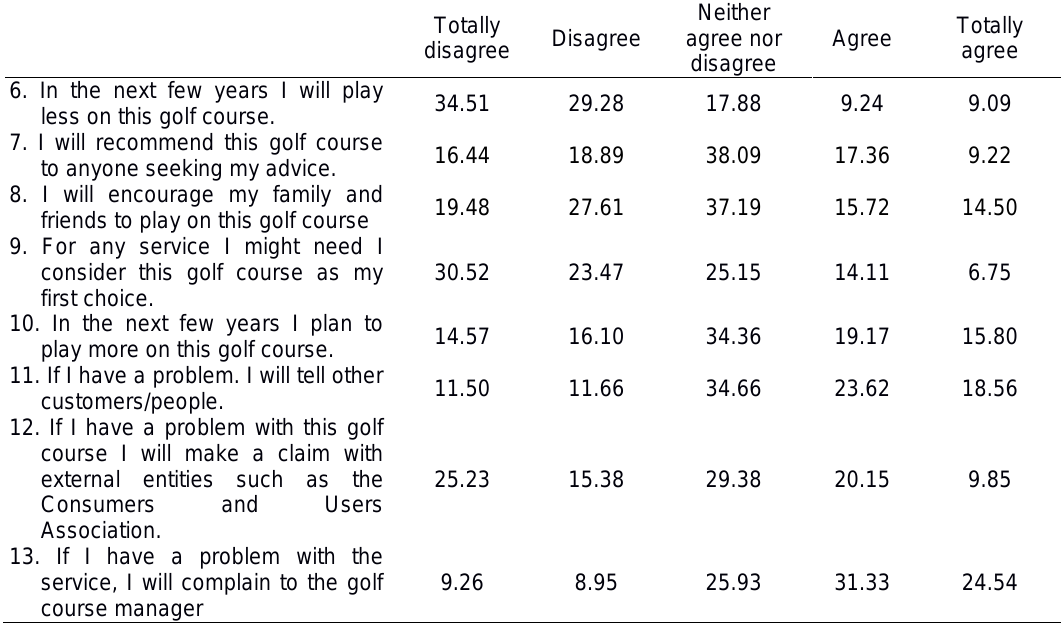
Table 2. Variables related to ‘Price sensation’ (V6-V19) and ‘response’ (V10-V13).